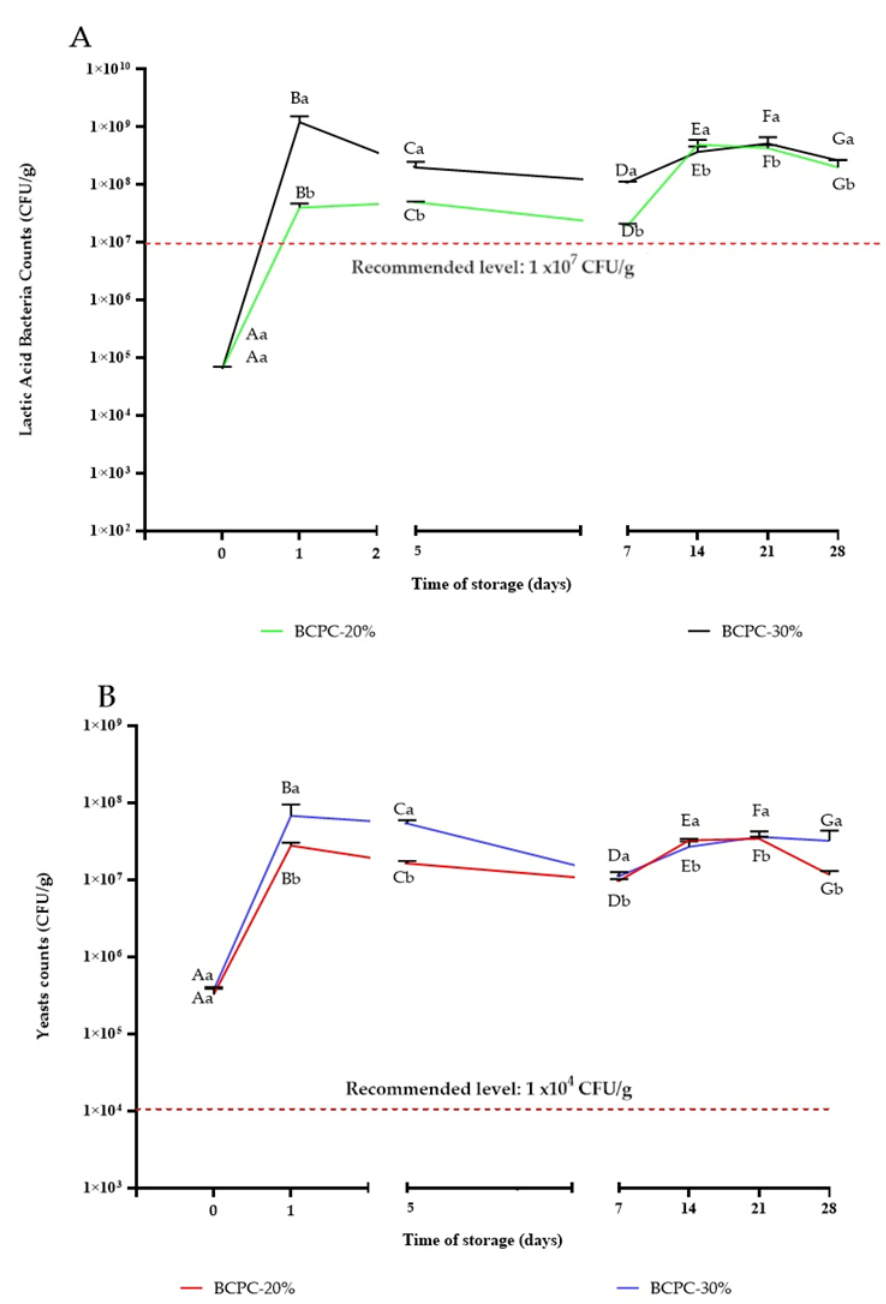
Figure 1. The lactic acid bacteria ( A ) and yeasts ( B ) viability during Figure 1 . The lactic acid bacteria ( A ) and yeasts ( B ) viability during storage .